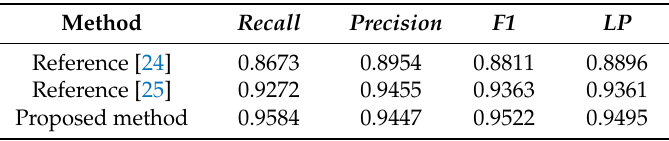
Table 4. Comparison of three methods on mixed